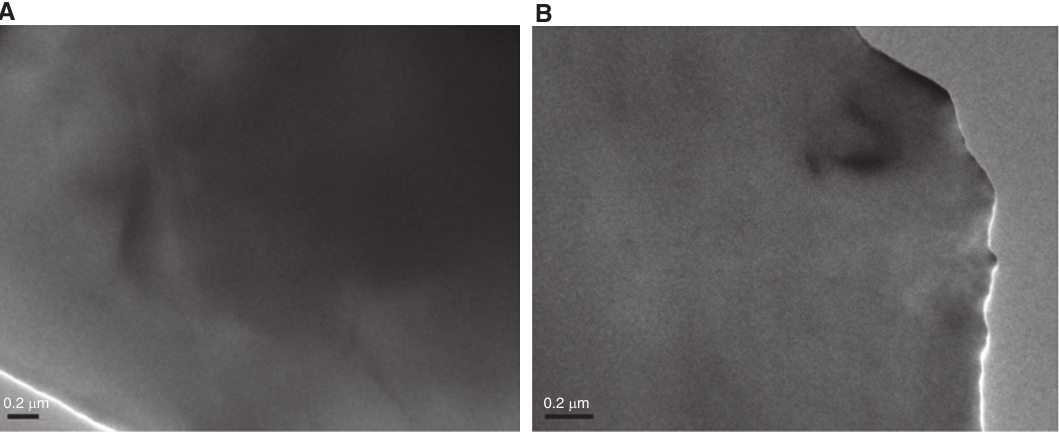
Figure 9: Transmittance electron microscopy (TEM) images of polyurethane (PU)-prepolymer (A) WPUDCO-1 and (B)